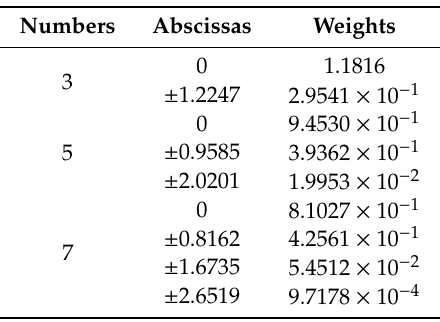
Table 1. Weights and abscissas for the Gauss–Hermite